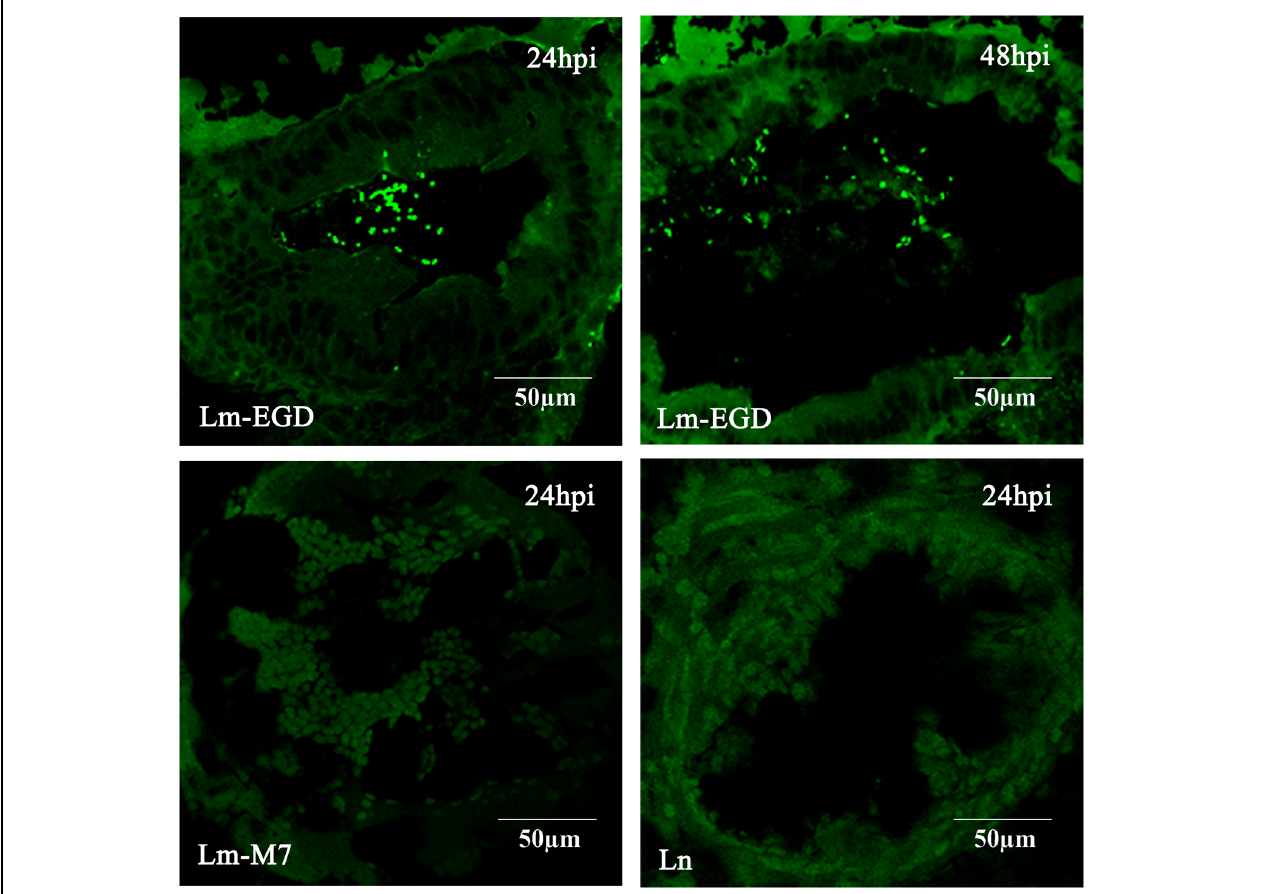
FIGURE 1 | Bacterial distribution in representative frozen sections of germ-free zebrafish infected at 5 dpf by 24 h of immersion with GFP-expressing listerial strain. Images were taken with the confocal microscope in samples taken at 24 and